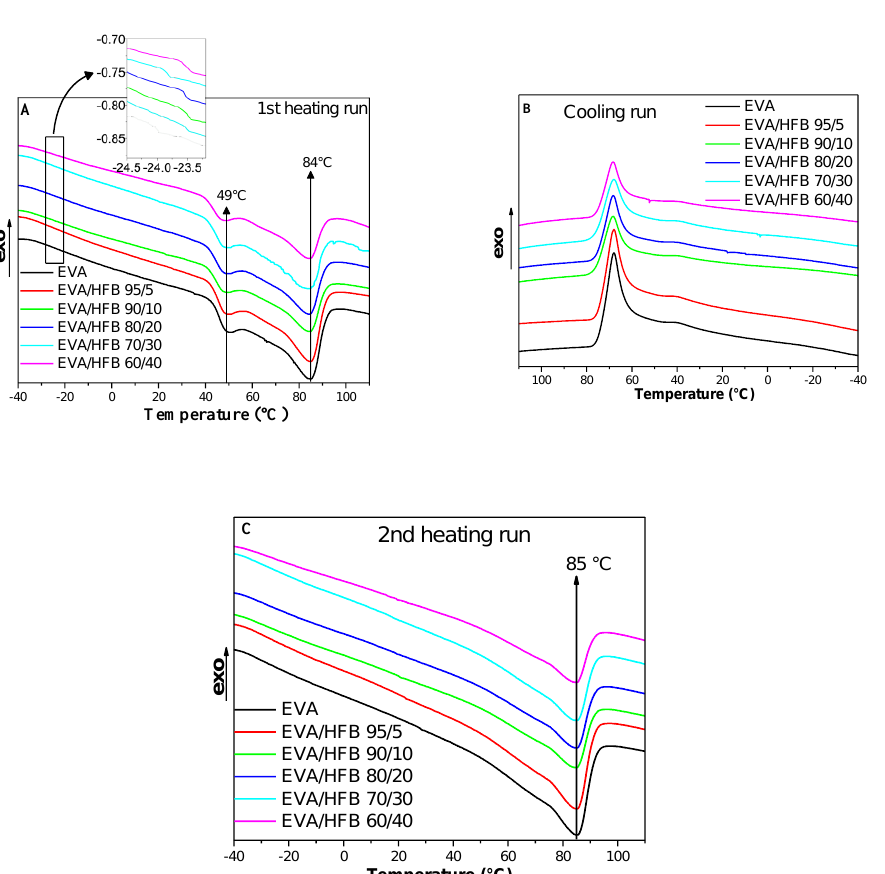
Figure 2. DSC curves of EVA and its composites: ( A ) first run from -40 °C to 120 °C; ( B ) cooling run